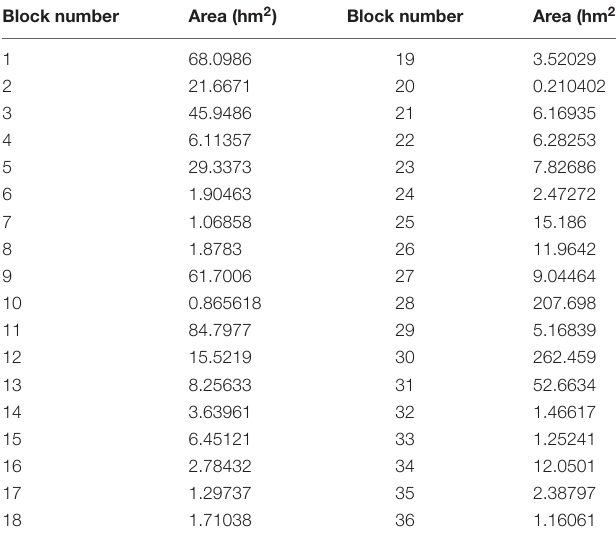
TABLE 4 | The area of different blocks.